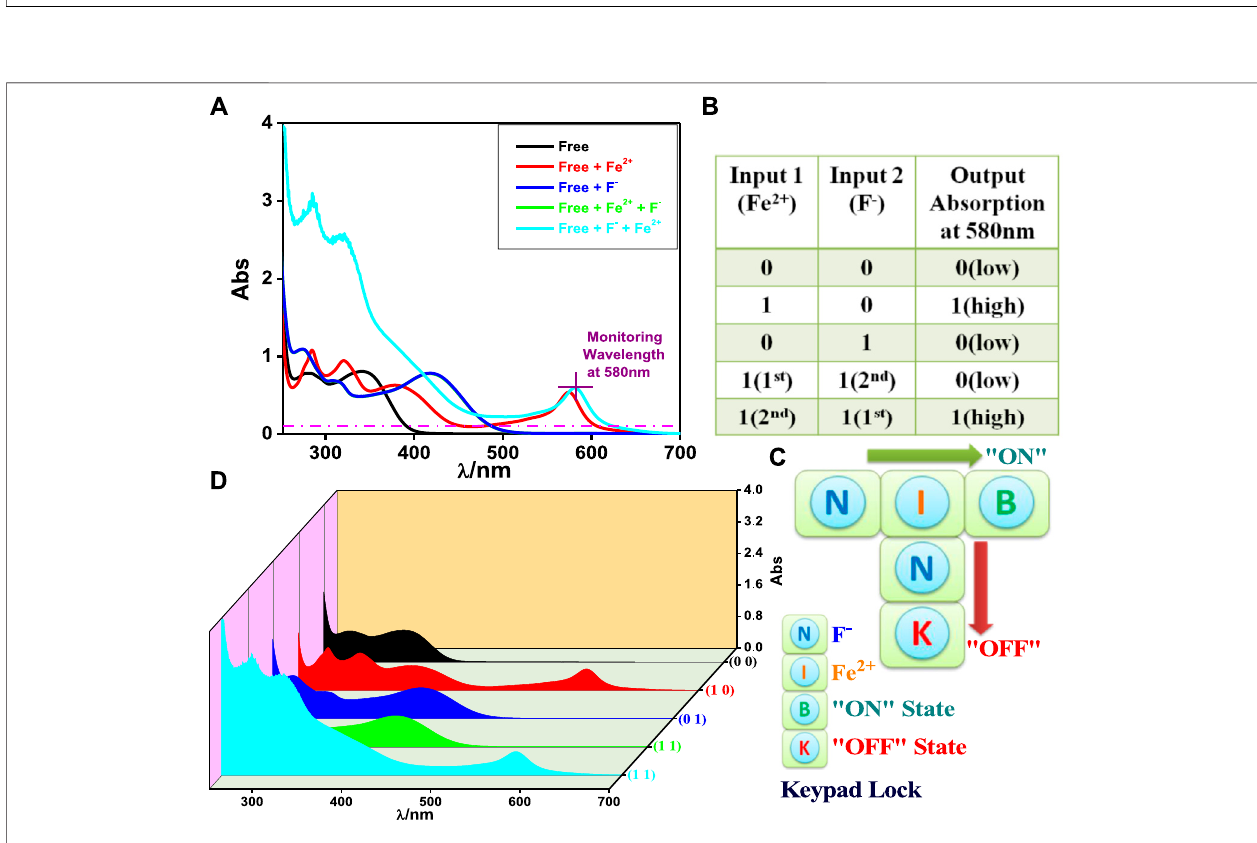
FIGURE4|(A) UV-Visabsorptionspectrumoftpy-HImzPh 3 uponinteractionwithF − andFe 2+ .Truthtableandschematicdisplayofthesecuritykeypadlock (B,C) . (D) 3D display of the variation of absorbance in the presence of the inputs.